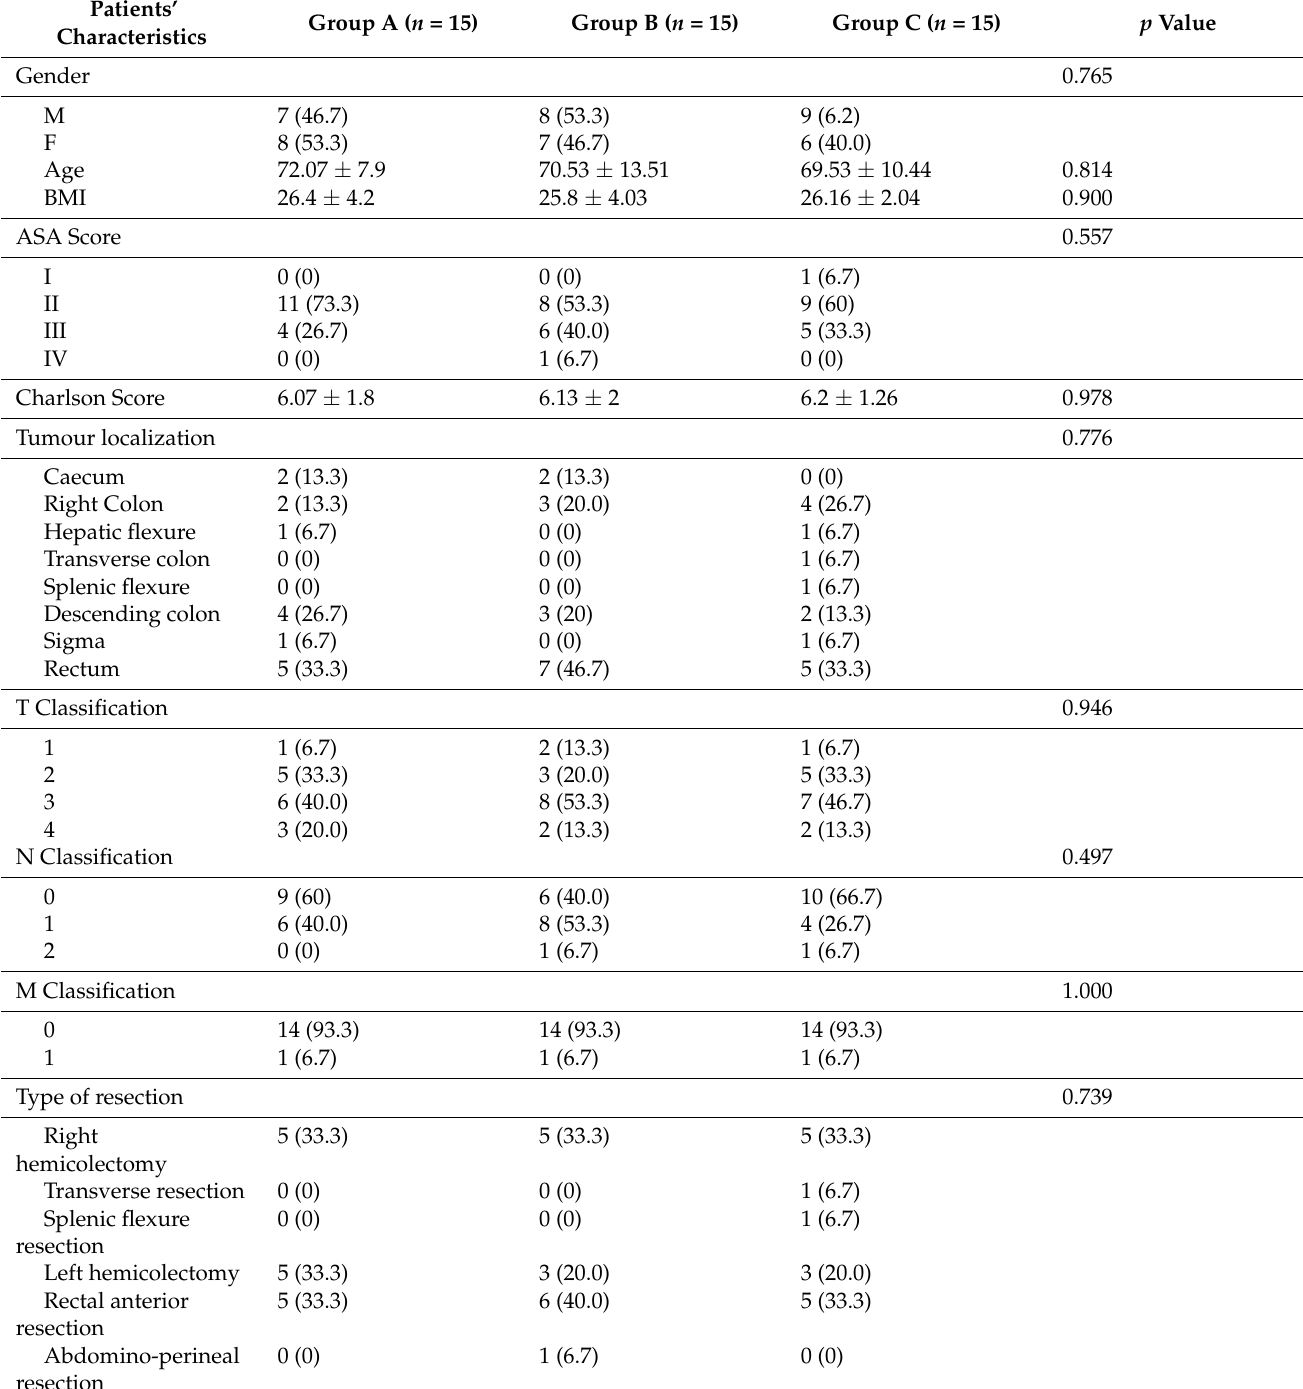
Table 1. Demographic data of the included